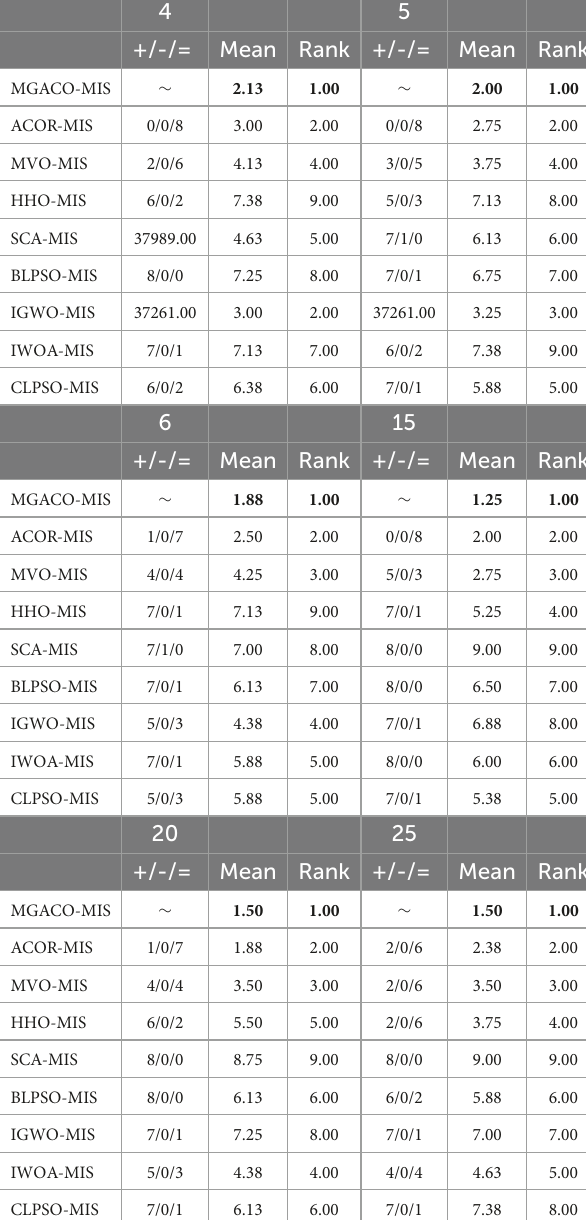
TABLE 6 The SSIM analysis results of MGACO and its peers at different threshold